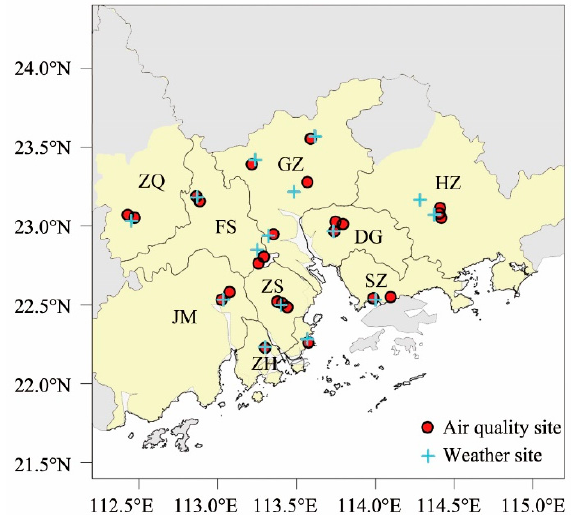
Figure 1. Spatial distribution of the meteorological observation sites and atmospheric environment monitoring sites in the Pearl River Delta (PRD) (meteorological observation sites: Weather site, Blue “+”; atmospheric environment monitoring sites: Air quality site, Red “ ● ”).